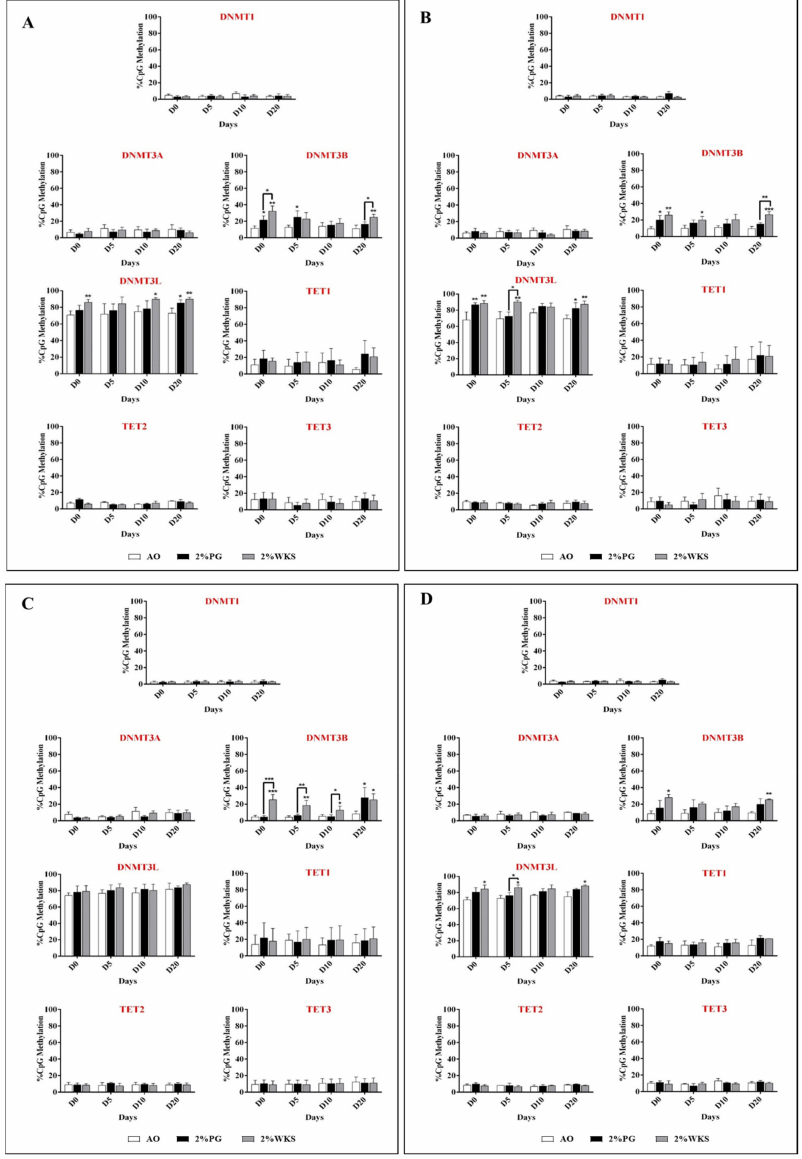
Figure 7. DNMT and TET promoter methylation in PSCs. ( A ) SHEF1 and ( B ) SHEF2, ( C ) ZK2012L, and ( D ) Pooled PSCs (SHEF1, SHEF2 and ZK2012L). CpG island methylation in DNMTs and TETs promoters were evaluated using pyrosequencing. Y -axis represents DNA methylation percentage at CpG regions. The X -axis represents time (days). Data are presented as mean ( n = 3), * p < 0.05, ** p < 0.01 and *** p < 0.001 vs. 21% AO, connecting lines indicate significance between conditions, and error bars indicate